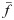
Selection for coexistence between strains with opposite handedness.Panel (A) shows that a left-handed mutant (shown in green) can invade a right-handed population (shown in red). The reverse invasion also occurs and is shown in panel (B). This negative frequency-dependent selection is further illustrated in panel (C), which shows how f‾, the spatially averaged relative abundance of the first strain, changes over time starting from different initial conditions. At t = 0, the strains are spatially separated in (A) and (B), but well-mixed in (C). In this figure, the strains have exactly opposite chiralities, but coexistence occurs more generally; see Fig 7. Note that the selection for coexistence relies on the presence of boundaries between the strains. When strains intermix (as shown in this figure), we observe a strong and time-invariant selection for coexistence. When strains do not intermix (see Figs 5 and 6), the number of boundaries slowly declines over time due to neutral coarsening [18, 41]. In such cases, robust coexistence relies on occasional external re-mixing events, e.g. during the establishment of a new colony. Here, m0 = ms = mb = md = 0, g = 0.1, N = 200 for both strains. ml(2)=0.09, mr(2)=0.01, ml(2)=0.01, mr(2)=0.09 on a lattice of 600x3000 sites. All distances were measured in 100 units where Δx = Δy = 1 unit.